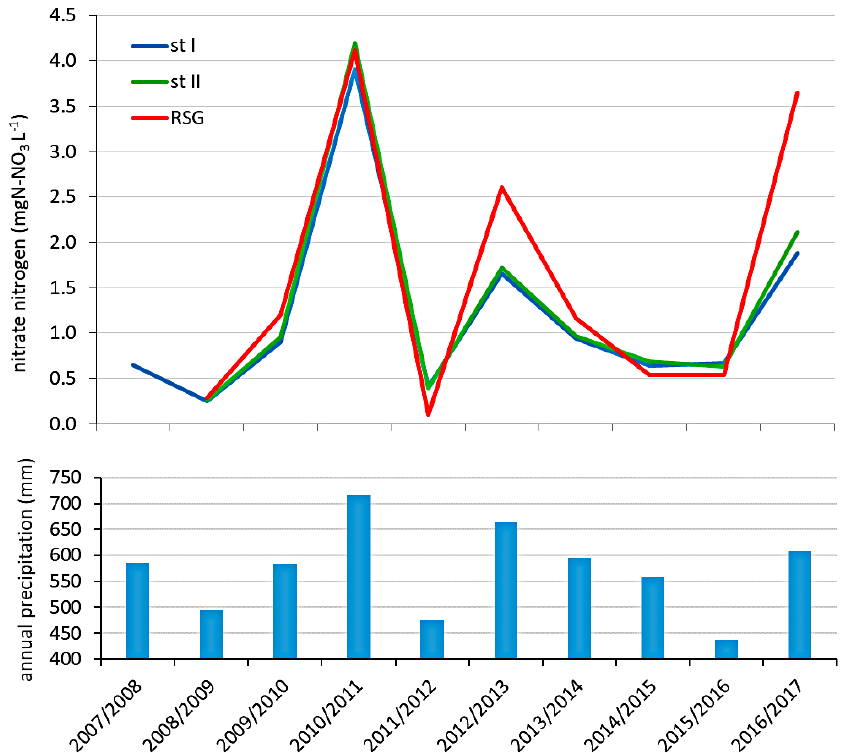
Figure 11. The dependence of nitrate concentrations at Station I, II and River Struga Gołaniecka (RSG) on the sum of annual precipitation from the previous year (first year on horizontal axis).